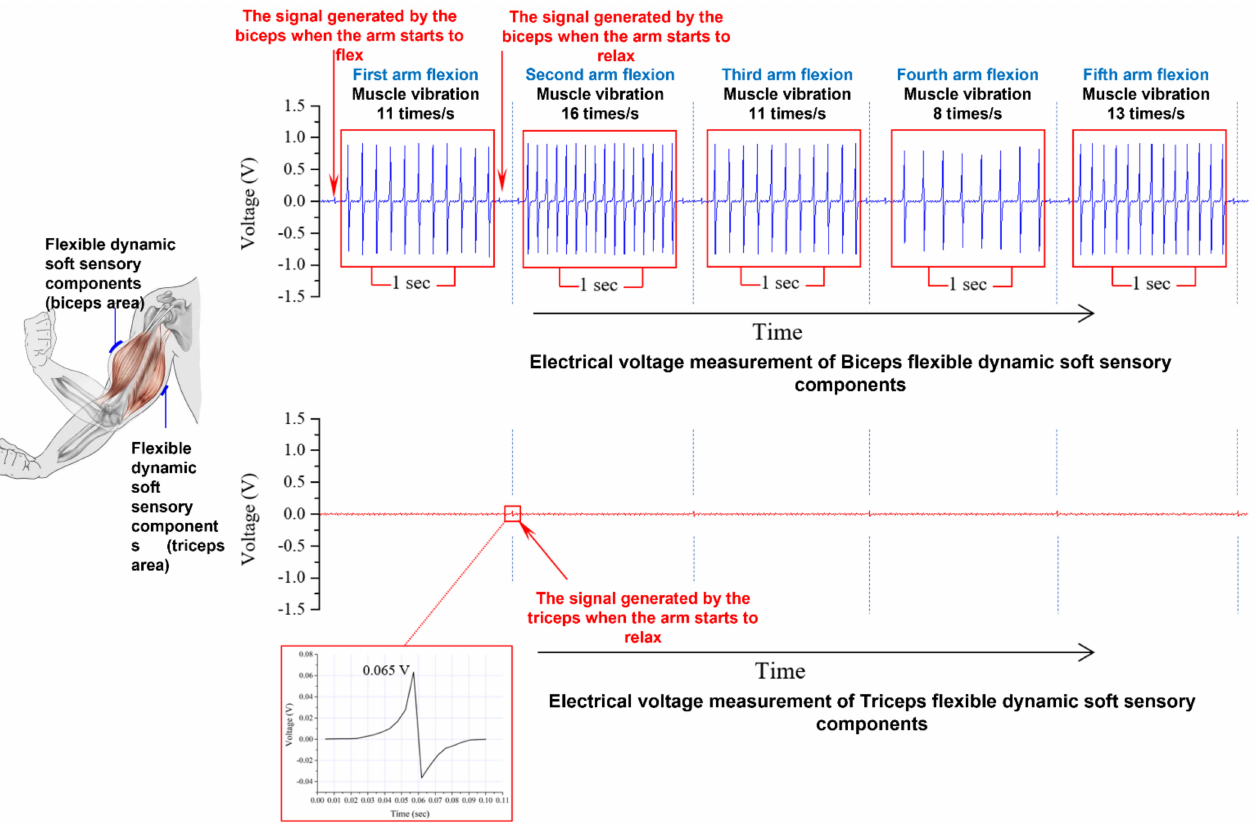
Figure 12. Data results of the trembling phenomenon when the human body continues to hold the dumbbell during a long period of exercise under a load that has exceeded the human body’s muscle